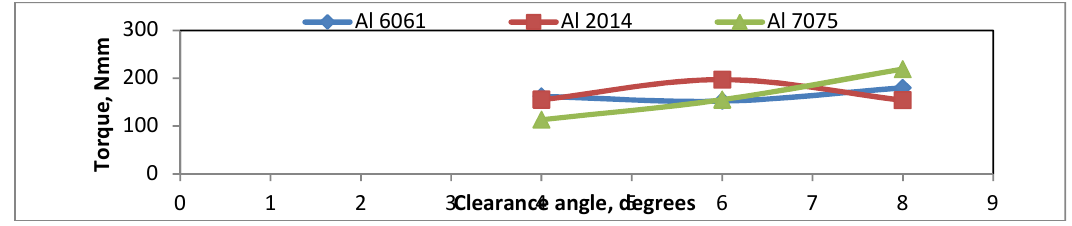
Fig. 14. Influence of alter the clearance angle on the torque (SET-1)